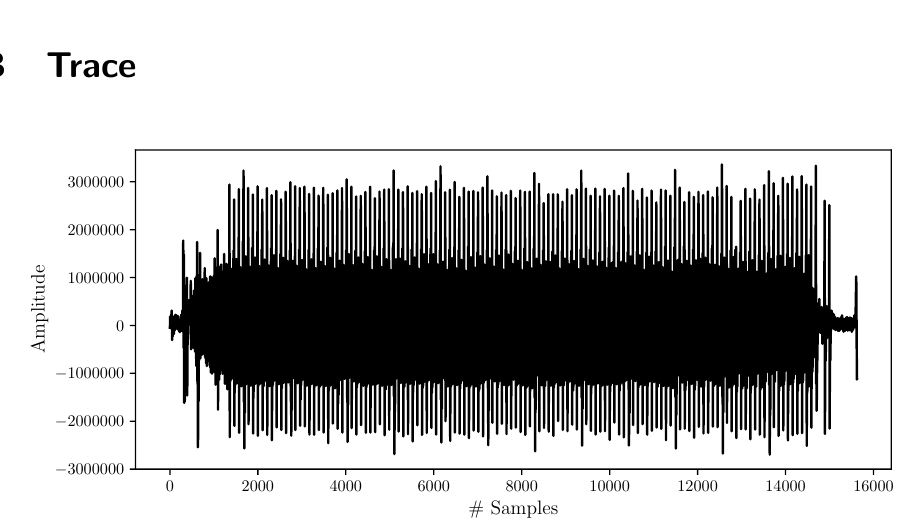
Figure 11: Plot of averaged EM trace covering 256 consecutive AES encryptions. Complete traces are used for the output-per-counter model illustrated in Figure 6b.